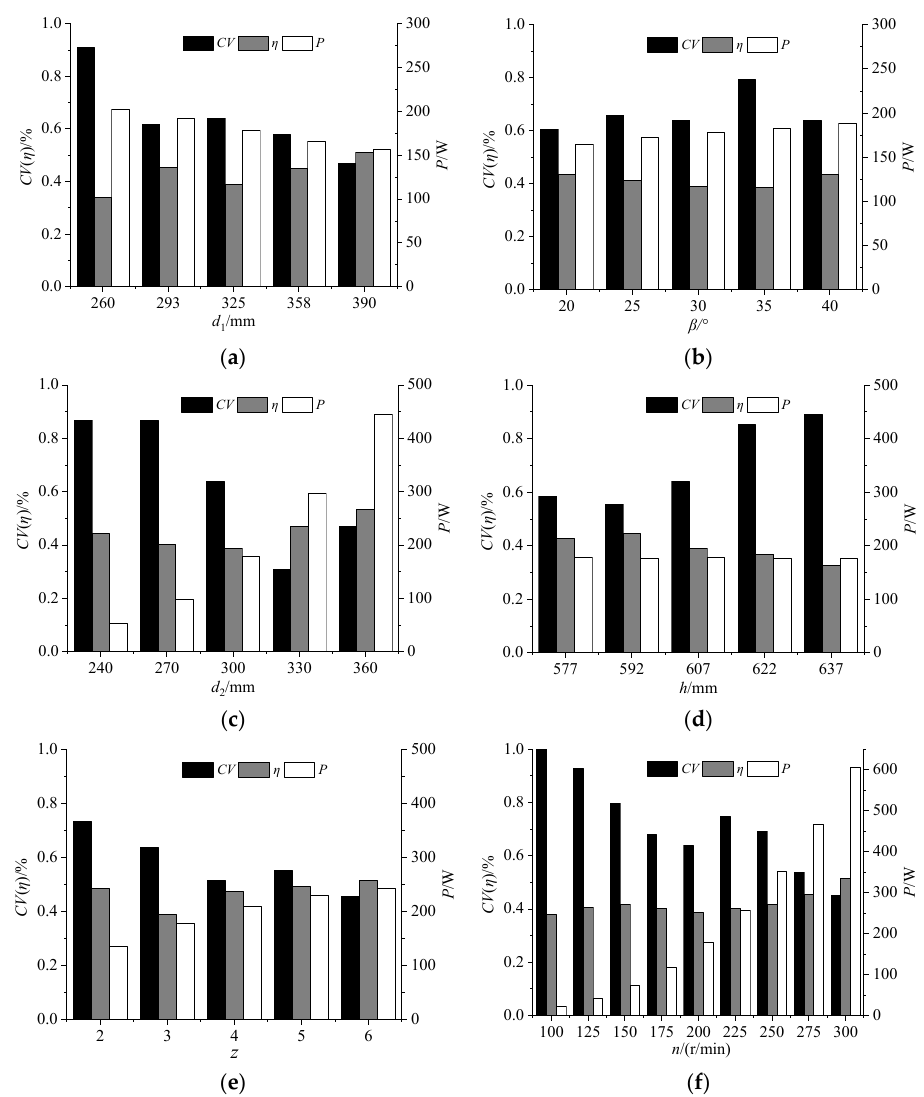
Figure 4. Comparison chart under different variables: ( a ) diameter of branch pipe; ( b ) angle of deflector; ( c ) impeller outer diameter ( d ) the installation height of impeller; ( e ) number of blades; ( f ) impeller speed.